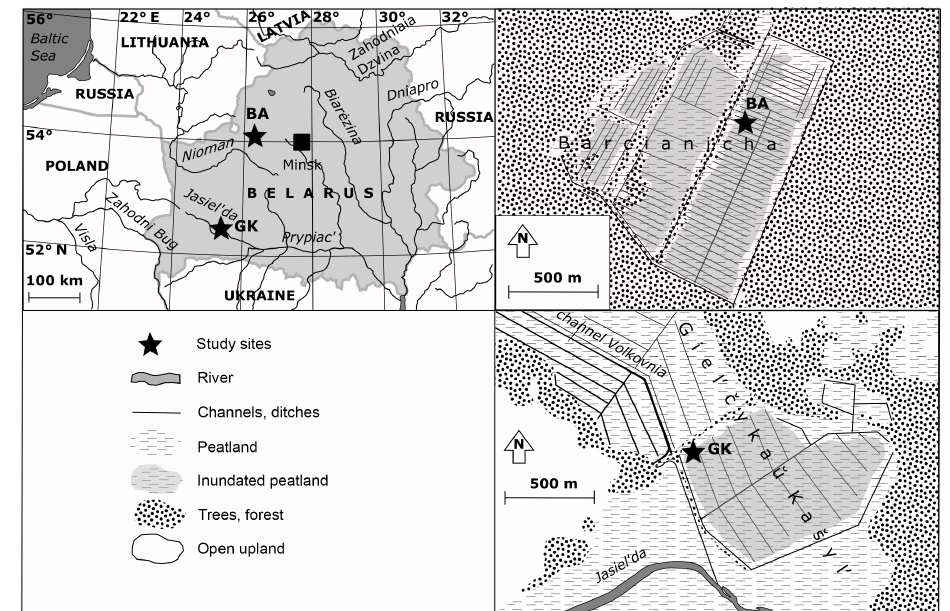
Figure 1. Location of the study